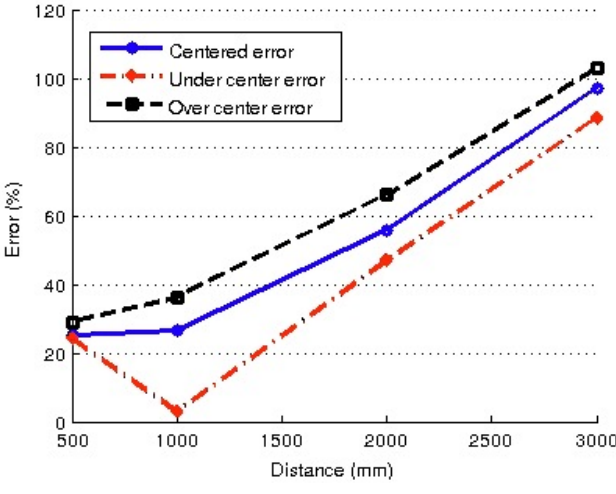
Figure 13. Errors in distance measurement when tested without adjustments.